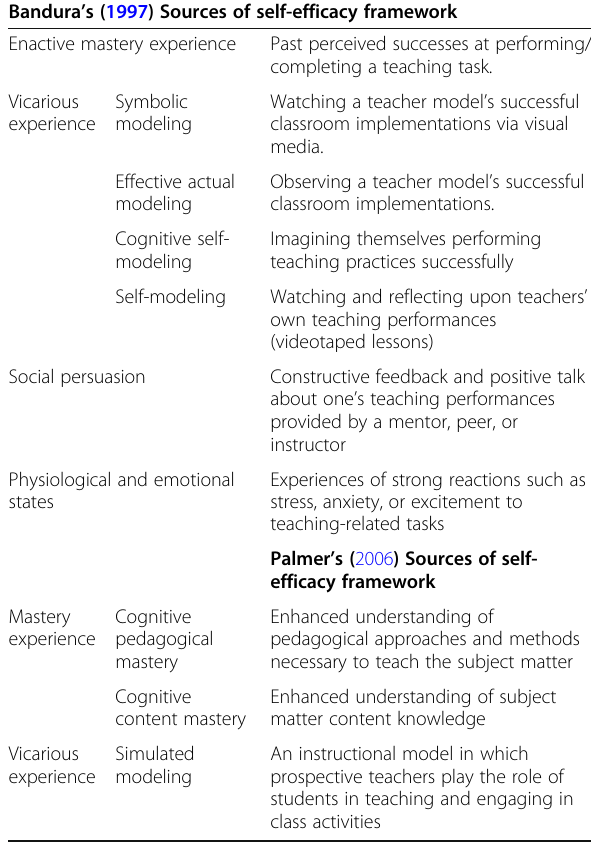
Table 1 Frameworks for sources of self-efficacy Bandura ’ s (1997) Sources of self-efficacy framework Enactive mastery experience Past perceived successes at performing/ completing a teaching task. Vicarious Symbolic experience